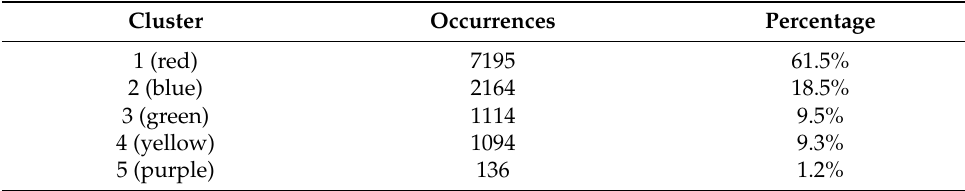
Figure 3. Keyword clustering view of eCO 2 RR from 2019 to 2022. Table 5. The occurrences and proportion of cluster keywords.